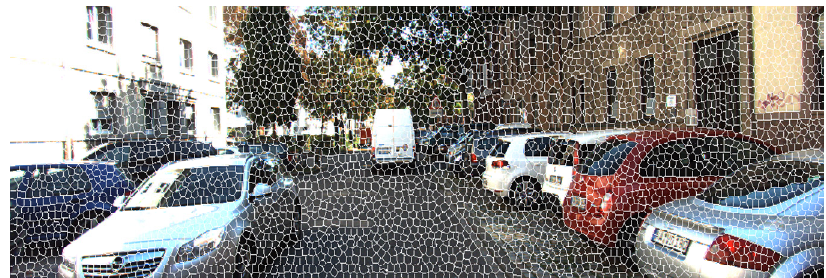
Figure 2. The segmentation result of the SLIC algorithm.